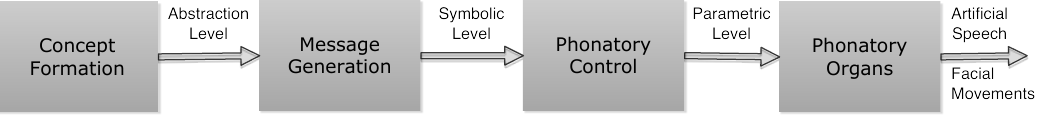
Figure 2. General scheme of communication that is used by our